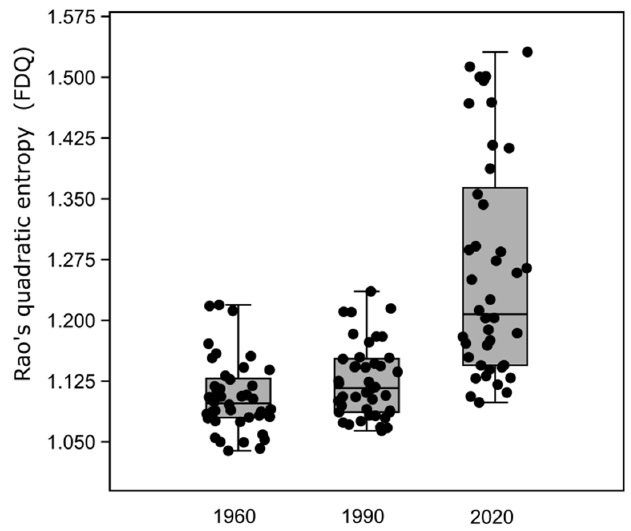
Figure 9. Summary box-and-whisker plots with jitters presenting changes in functional diversity FD Q (Rao’s quadratic entropy) within herb layer species for three studied surveys of the riparian forest in the Odra River Valley (SW Poland). The central line of each box indicates the median value, box boundaries the lower (25%) and upper (75%) quartiles, and whiskers the range of values.